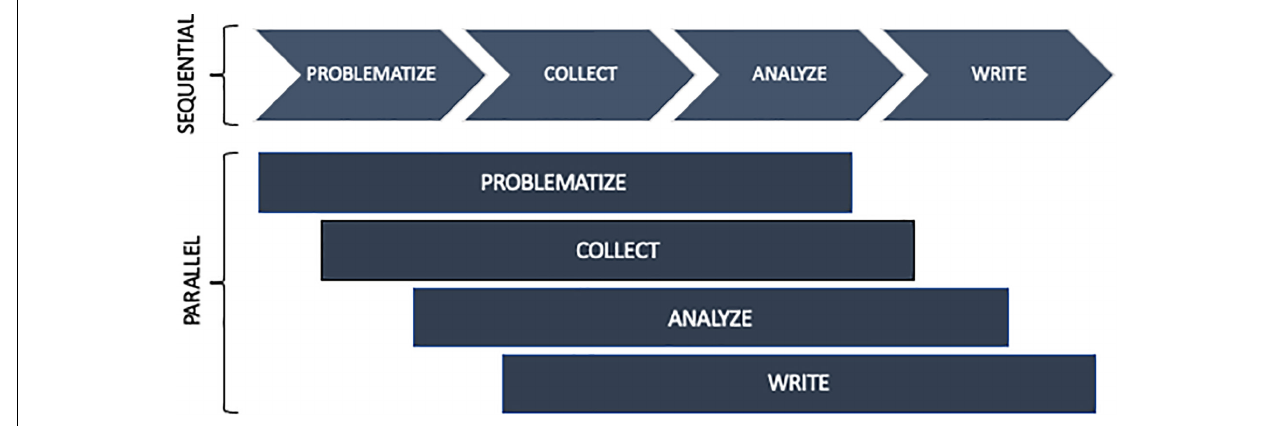
FIGURE 1 | Parallel organization of the research (Lejeune,